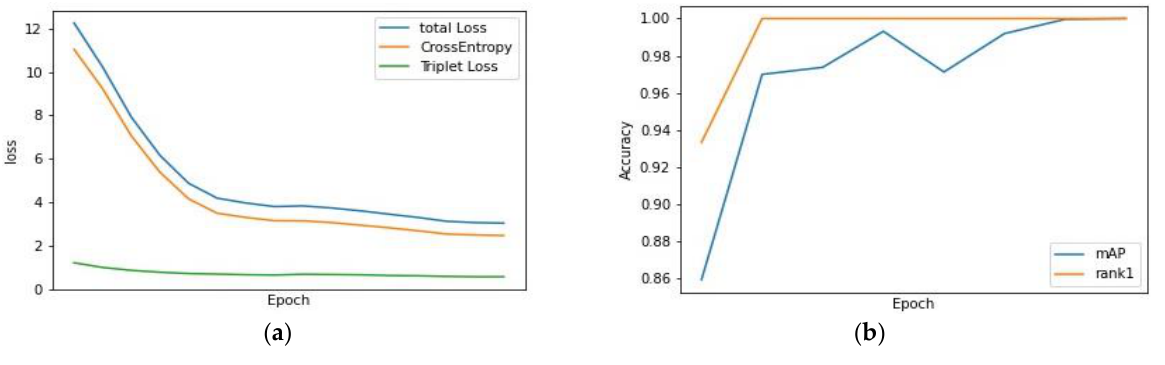
Figure 13. PREID ( a ) training loss ( b ) validation.